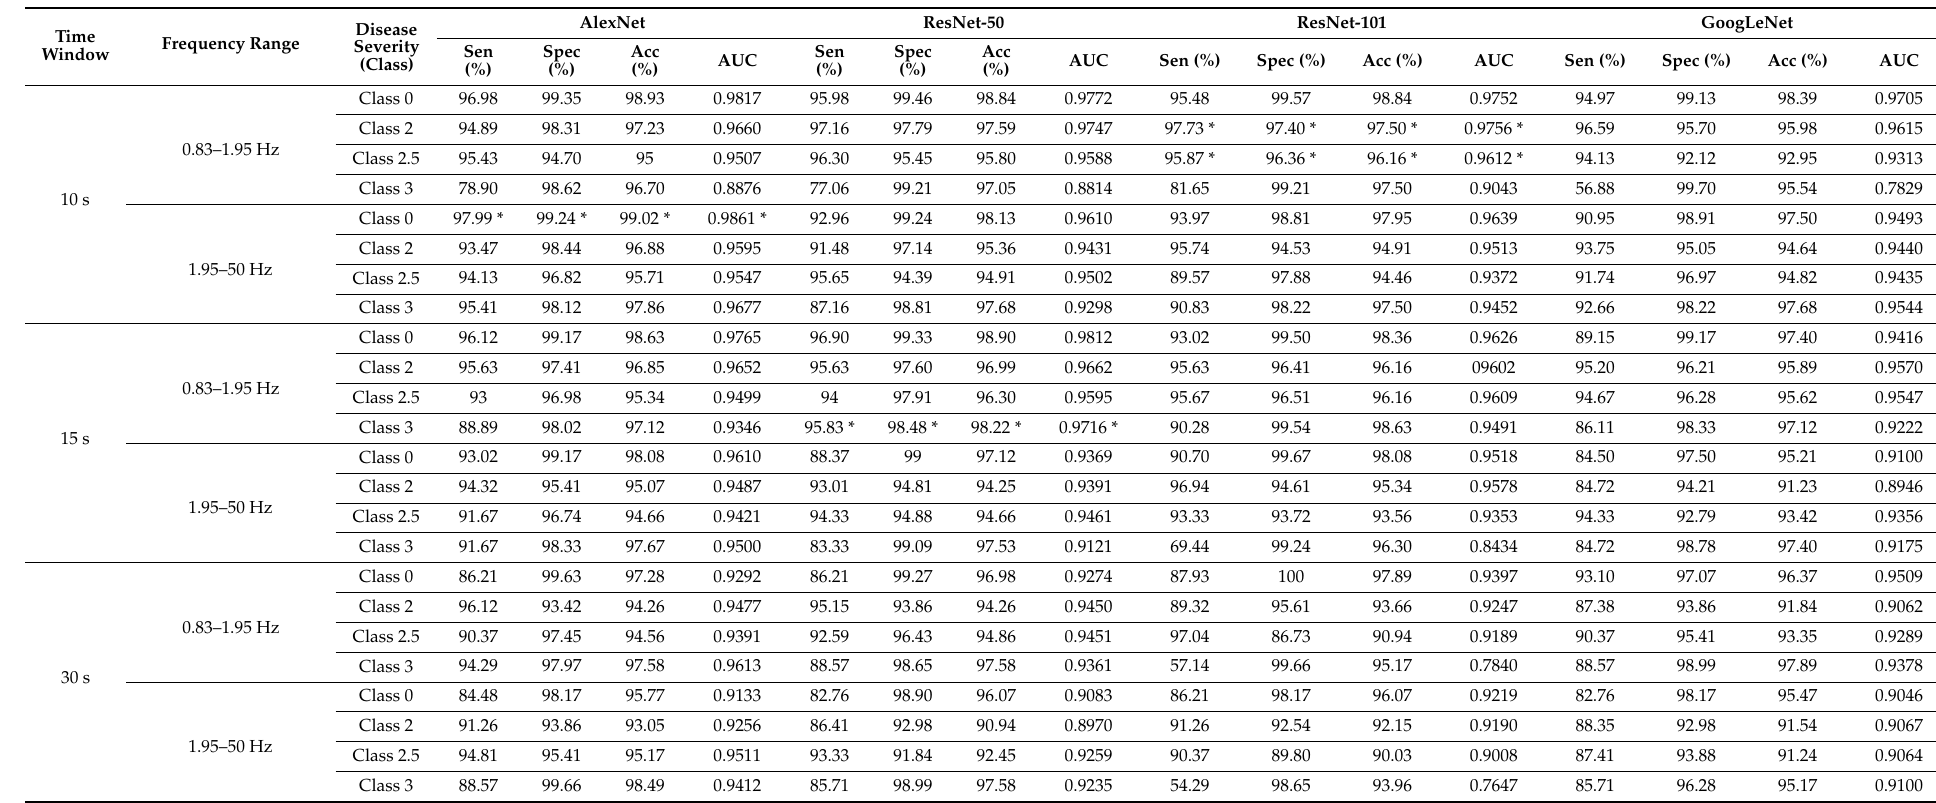
Table 9. Multi-class classification of RF from Ju dataset for CO (Class 0), PD Stage 2 (Class 2), PD Stage 2.5 (Class 2.5), and PD Stage 3 (Class 3) using several CNN classifiers (AlexNet, ResNet-50, ResNet-101, and GoogLeNet) with 10-fold